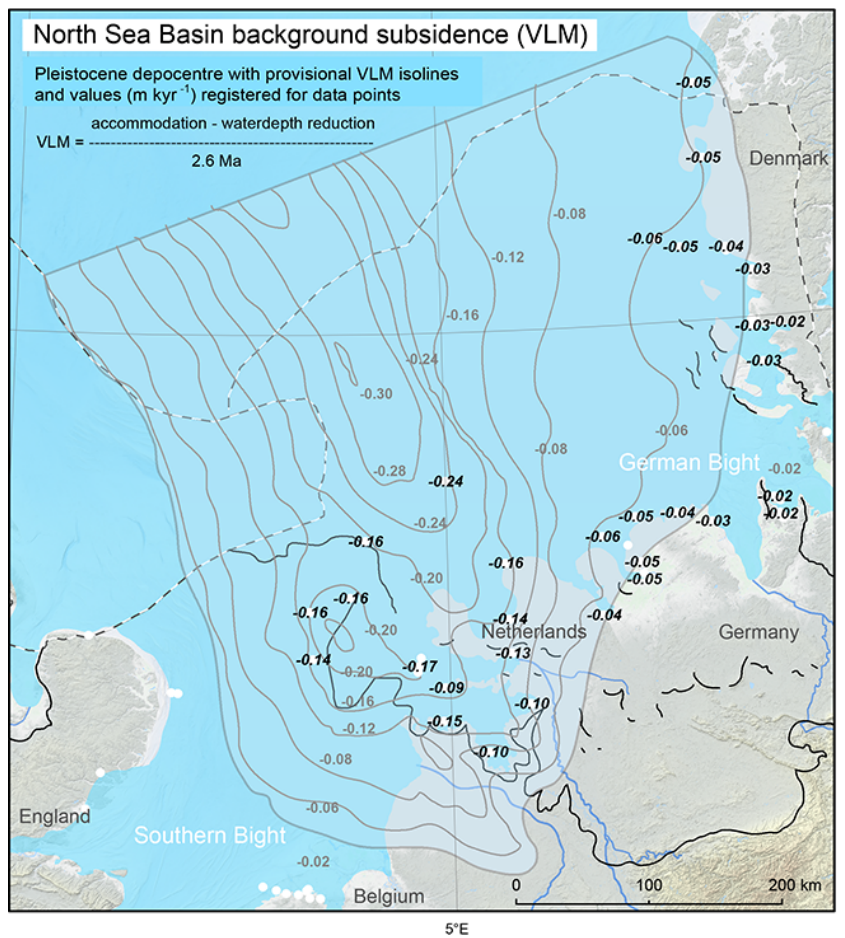
Figure 3. VLM rates (mkyr − 1 ) for North Sea basin LIG data points. Area of subsidence and VLM contours, based on depth of base Pleistocene in marine formations (onshore and offshore data from NL, GER and DK geological surveys), negotiated for water depth reduction during the Early Pleistocene (isoline increment: 0.04mkyr − 1 , i.e. equivalent to 5m RSL correction accumulated over 120kyr). Values in black italics: WALIS VLM entries for LIG data points, reproducing Kooi et al. (1998) for the Netherlands. Offshore subsidence patterns deviate subtly from the 1998 publication, and for the German Bight coverage was extended based on improved mapping of base Pleistocene. Backdrop as in Fig. 1, containing land data © OpenStreetMap contributors 2020. Distributed under the Open Data Commons Open Database License (ODbL)